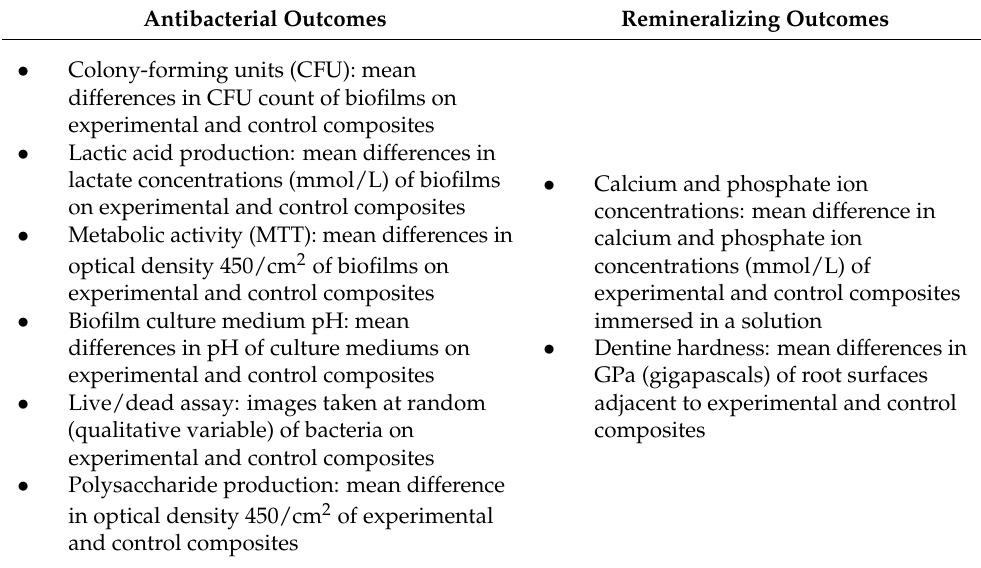
Table 2. Tests for antibacterial and remineralizing